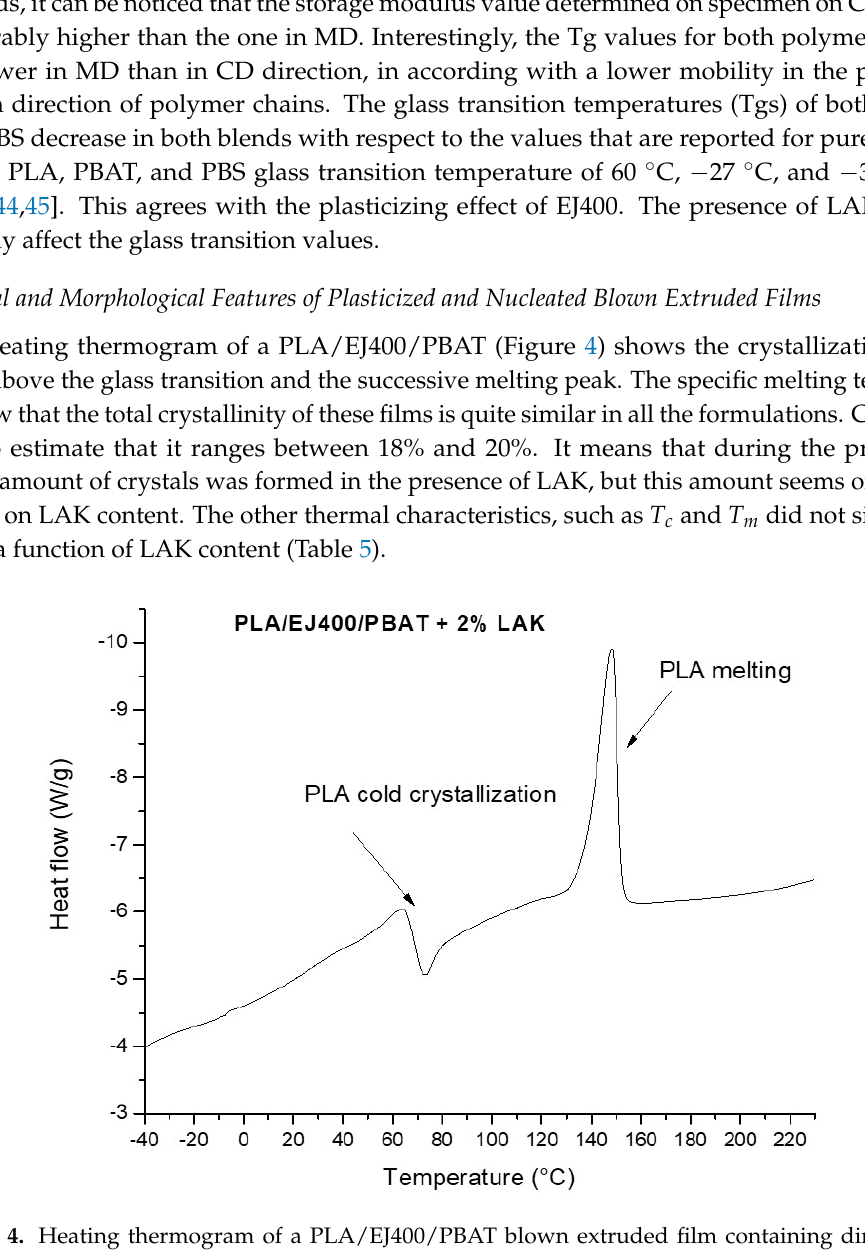
Figure 4. Heating thermogram of a PLA/EJ400/PBAT blown extruded film containing dimethyl 5-sulfoisophthalate, potassium salt (LAK).